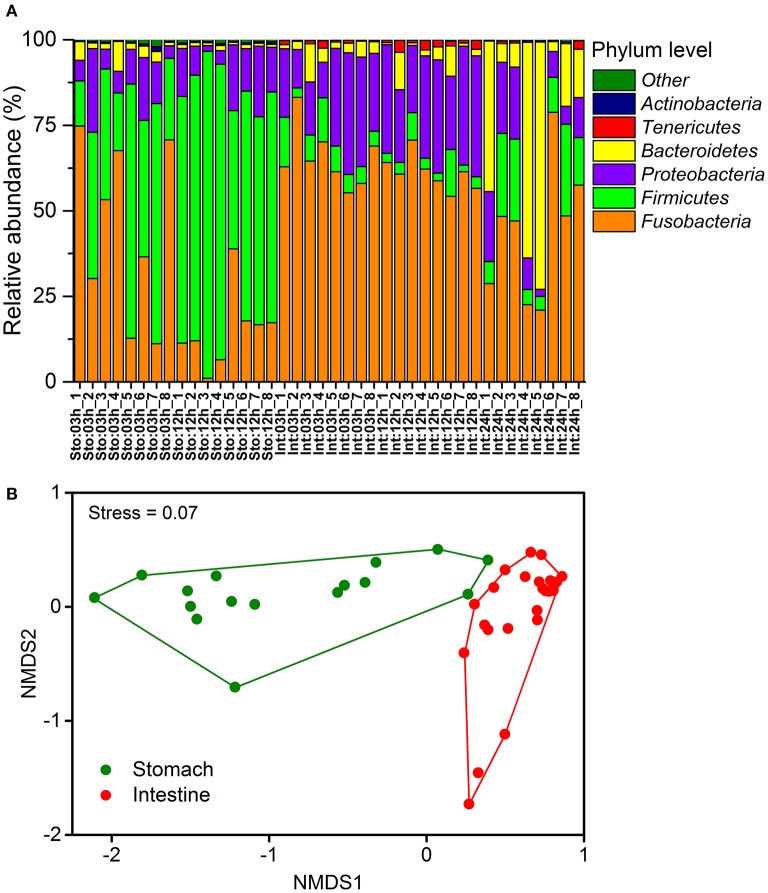
Temporal dynamics in microbial community compositions of the gastrointestinal tract of southern catfish after feeding. (A) Relative abundance of the phyla of all samples at 03, 12, and 24h after feeding; (B) Non-metric multidimensional scaling ordinance based on a distance matrix computed with Bray-Curtis distance.